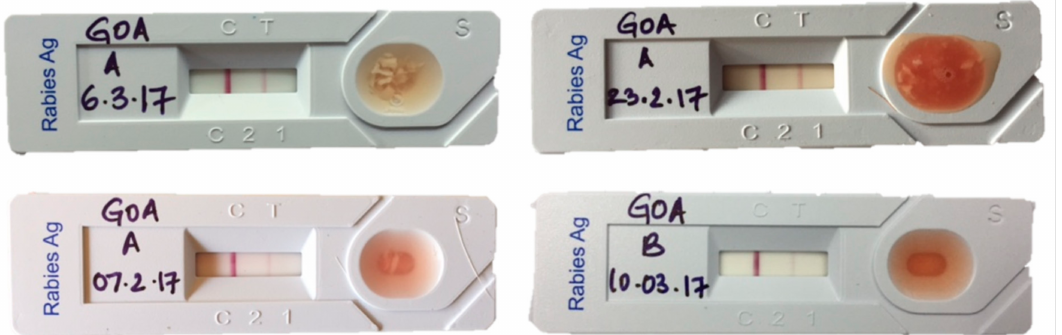
Figure 3. LFAs showing an adequate chromogenic change in the control band and a faint positive line in the test band. These samples were confirmed positive by dFT.